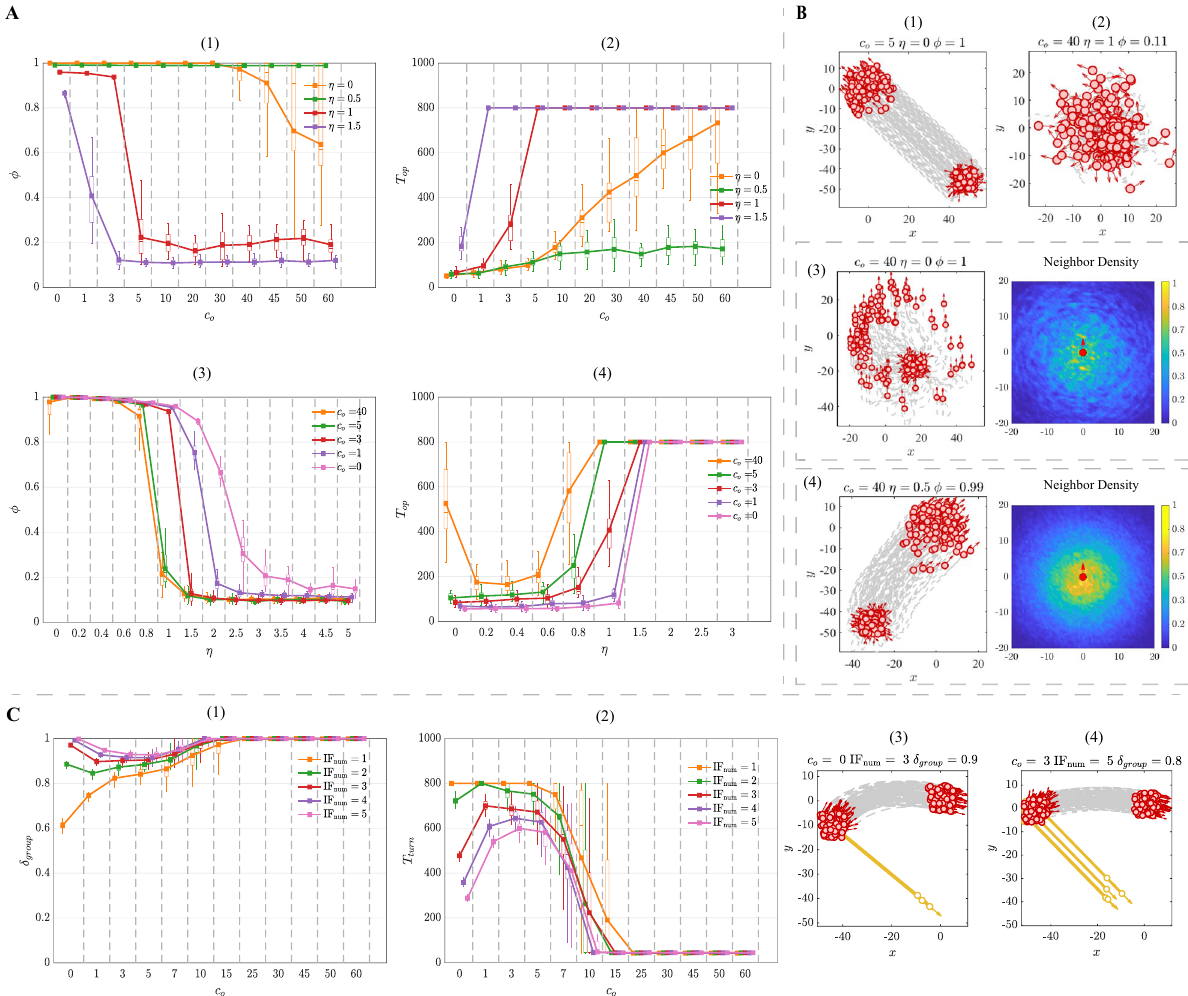
Figure 5. ( A ) The property of flocking as the evolution of c o and η in the DYO-S model. ( A -(1)) The polarization φ as a function of c o . ( A -(2)) The convergence time T op as a function of c o . ( A -(3)) The polarization φ as a function of noise η . ( A -(4)) The convergence time T op as a function of noise η . ( B ) The trajectories of flocking with different c o . ( C ) The property of responsivity to stimulus with the evolution of c o in the DYO-S model. ( C -(1)) The response accuracy δ group as a function of c o . ( C -(2)) The response time T turn as a function of c o . ( C -(3–4)) The trajectories of response to stimulus with different c o . T op = 800 or T turn = 800 indicate that the group is unable to finish the corresponding case within the total simulation time. Each data point represents the average of 50 simulation runs with the boxplot.Boxplots in the block divided by the dotted line belong to the same data point but are shifted at different positions on the x-axis to be more